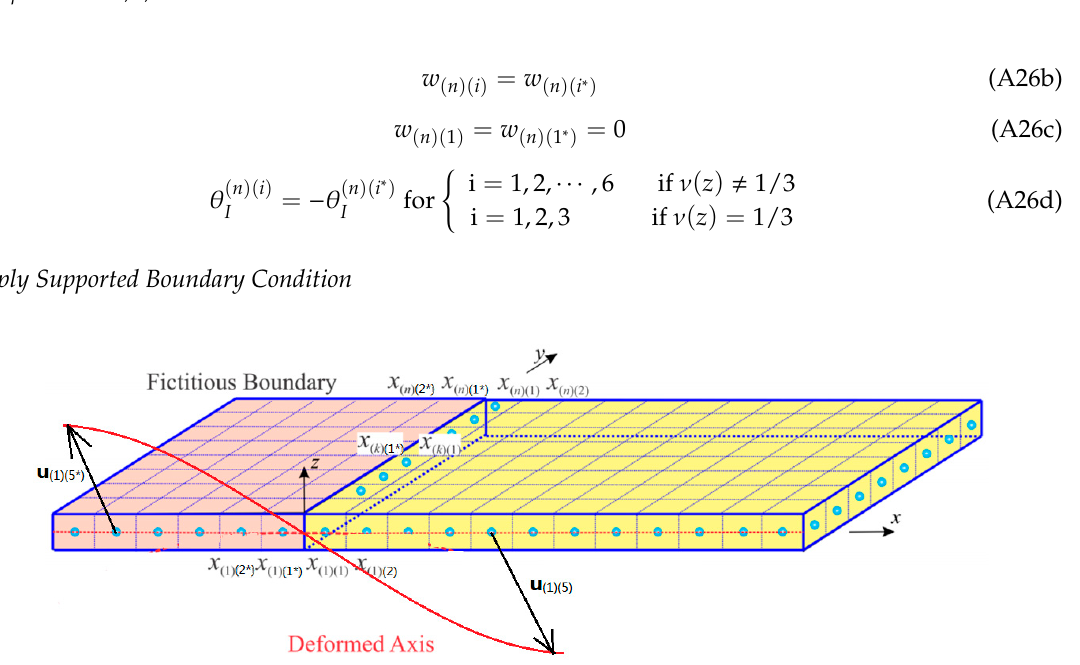
Figure A4. Application of simply supported boundary condition in peridynamic Figure B3. Application of simply supported boundary condition in peridynamic theory.